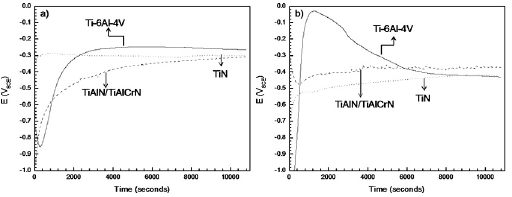
Figure 2. Open circuit potential vs. time for uncoated, TiN, and TiAlN/TiAlCrN coated Ti–6Al–4V alloy, in 2 M NaOH: a) at 25 °C, b) at 60 °C.